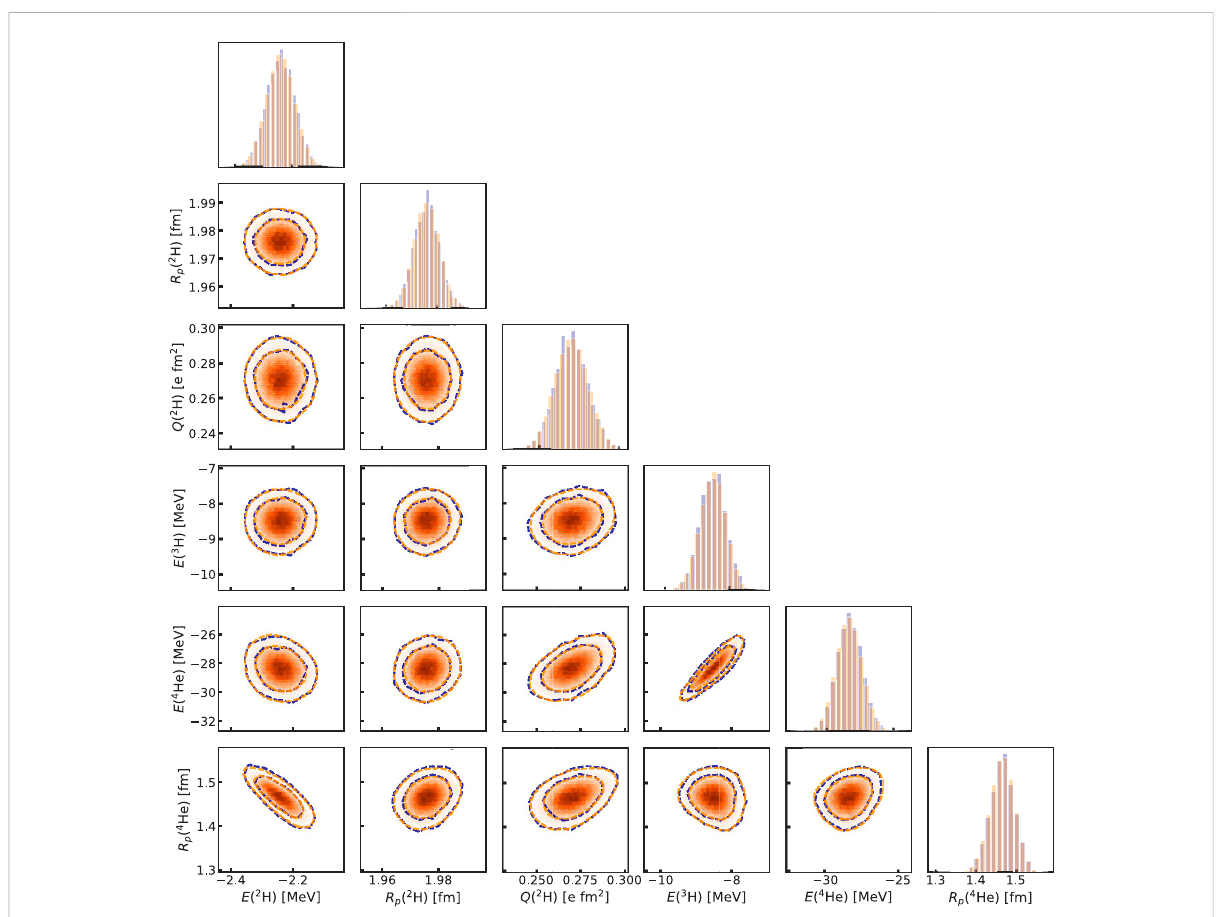
FIGURE 3 The PPD obtained from samples of the LECs posterior distribution as shown in Figure 2. The bivariate histograms and the corresponding contour lines denote the joint distribution of observables generate by S/IR (blue) and MCMC sampling (orange). The marginal distributions of the observables are shown in the diagonal